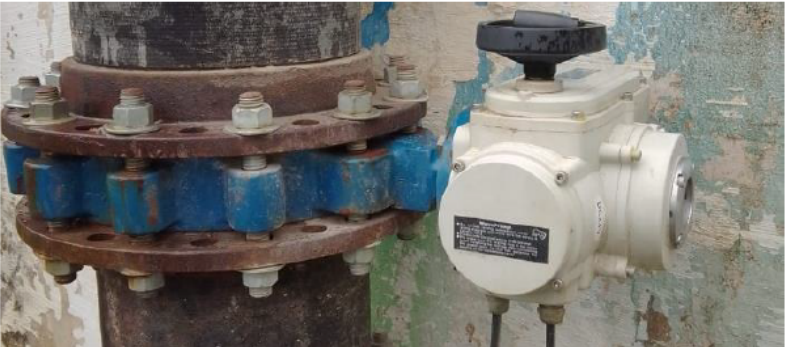
Figure 8. Support reservoir valve. Source: